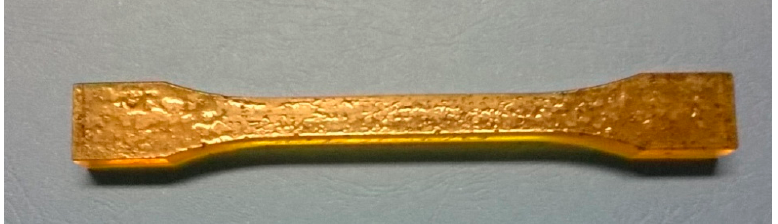
Figure 3. Specimens of the cured adhesive after 7 days of curing.